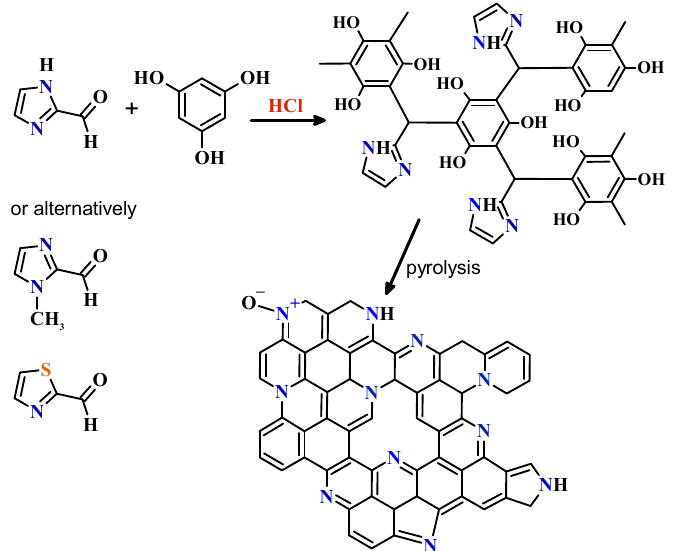
Figure 1. Schematic representation of imidazole-based N-doped carbons synthesis (1-methylimidazole-2-carboxaldehyde and 2-thiazolecarboxaldehyde can be used instead of imidazole-2-carboxaldehyde).